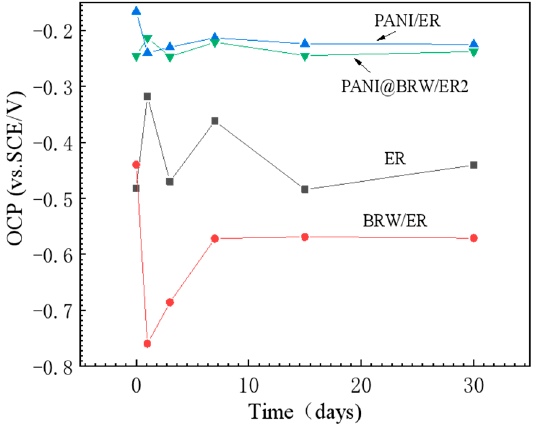
Figure 9. Open circuit potential (OCP) of ER, BRW/ER, PANI/ER, and PANI@BRW/ER coatings.